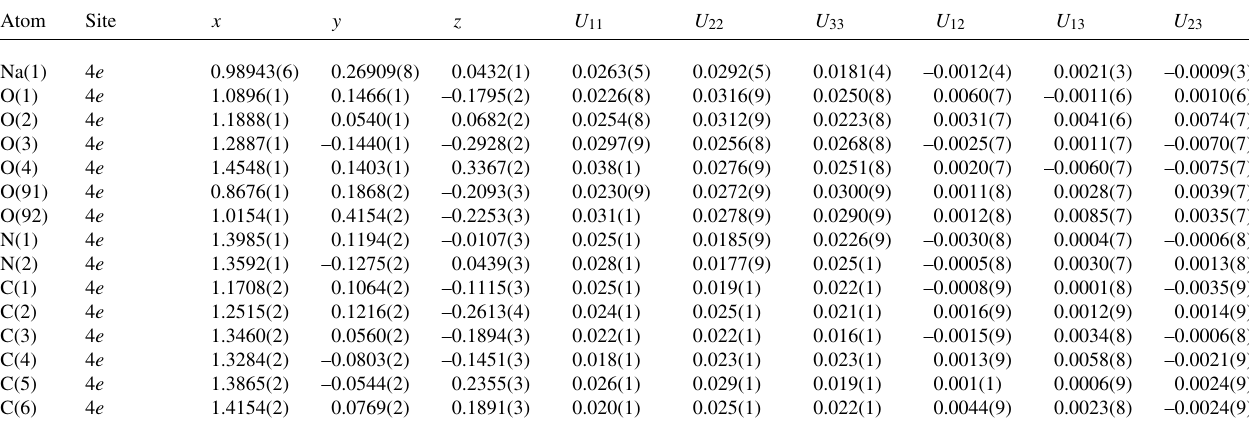
Table 3. Atomic coordinates and displacement parameters (in Å 2 )